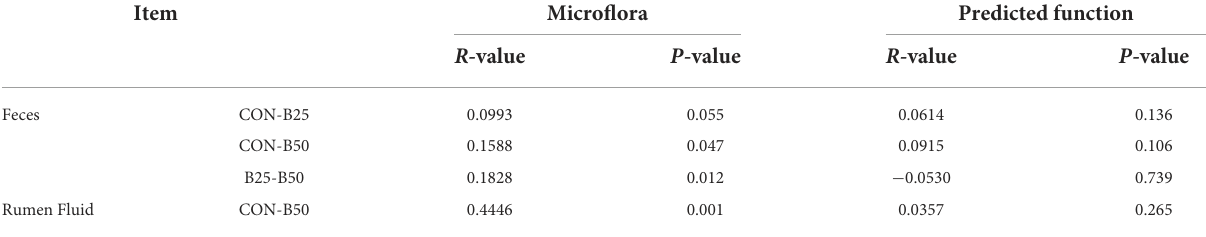
TABLE 4 Analysis of similarities (ANOSIM) of the composition and predicted function in fecal and rumen fluid microflora.